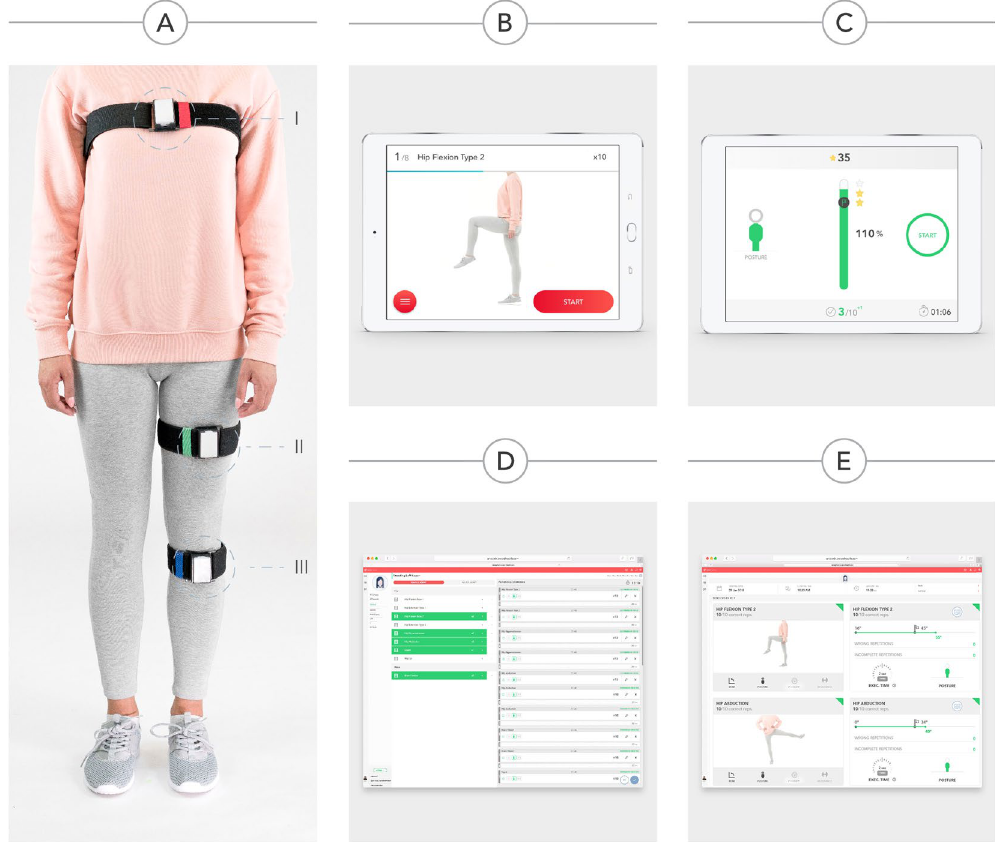
Figure 3. System components. ( A ) Motion Tracker Setup. ( B ) Mobile App: preparation screen. This screen is shown before each exercise, and displays a video of the exercise, as well as audio instructions. ( C ) Mobile App: execution screen. This screen is shown during exercise execution, displaying: (a) timer; (b) progress bar; (c) posture dummy; (d) repetition counter; (e) time left; ( C ) Web Portal - prescription screen. This screen